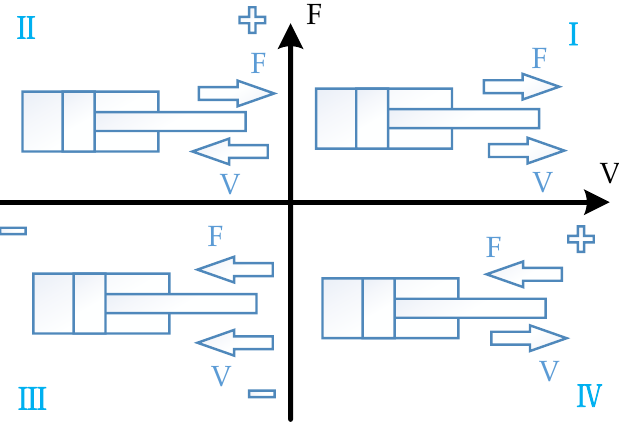
Figure 4. From the first quadrant to the fourth quadrant, overrunning extension, resistive retraction, overrunning retraction and resistive extension are shown. Taking the work of the excavator boom as an example, the load on the boom hydraulic cylinder is mainly the total weight of the mechanical arm and the goods in the bucket. Its direction is the retraction direction of the hydraulic cylinder. Therefore, the working mode of the boom hydraulic cylinder is mainly in the third and fourth quadrants. When the boom cylinder is extended, the boom is lifted. At this time, the working mode is resistive extension. When the boom cylinder is retracted, the boom is lowered. At this time, the working mode is overrunning retraction.